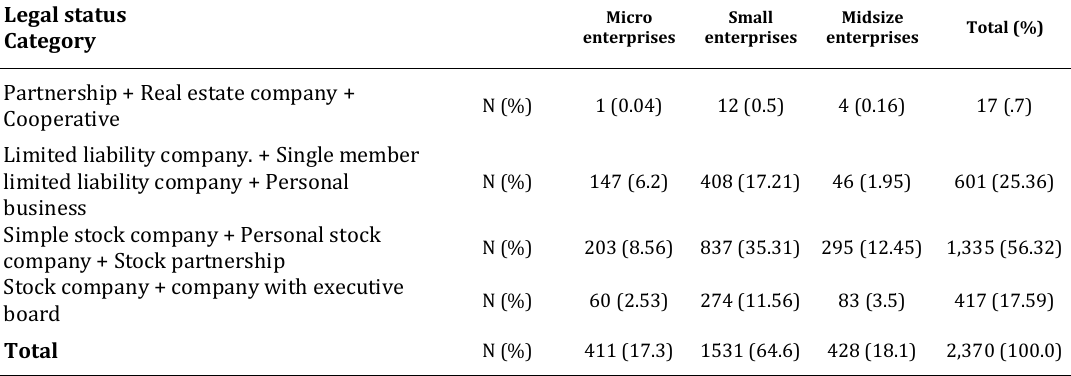
Table 2. Distribution of SMEs categories according to their legal